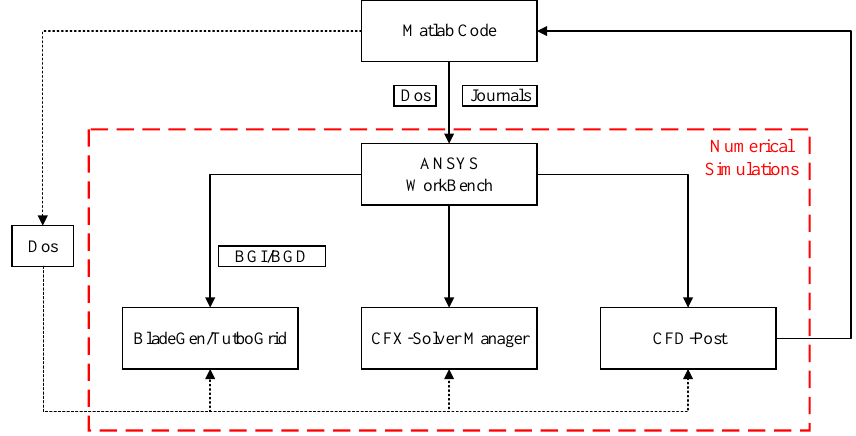
Figure 10. Schematic diagram of the control process of the improved bat algorithm program.